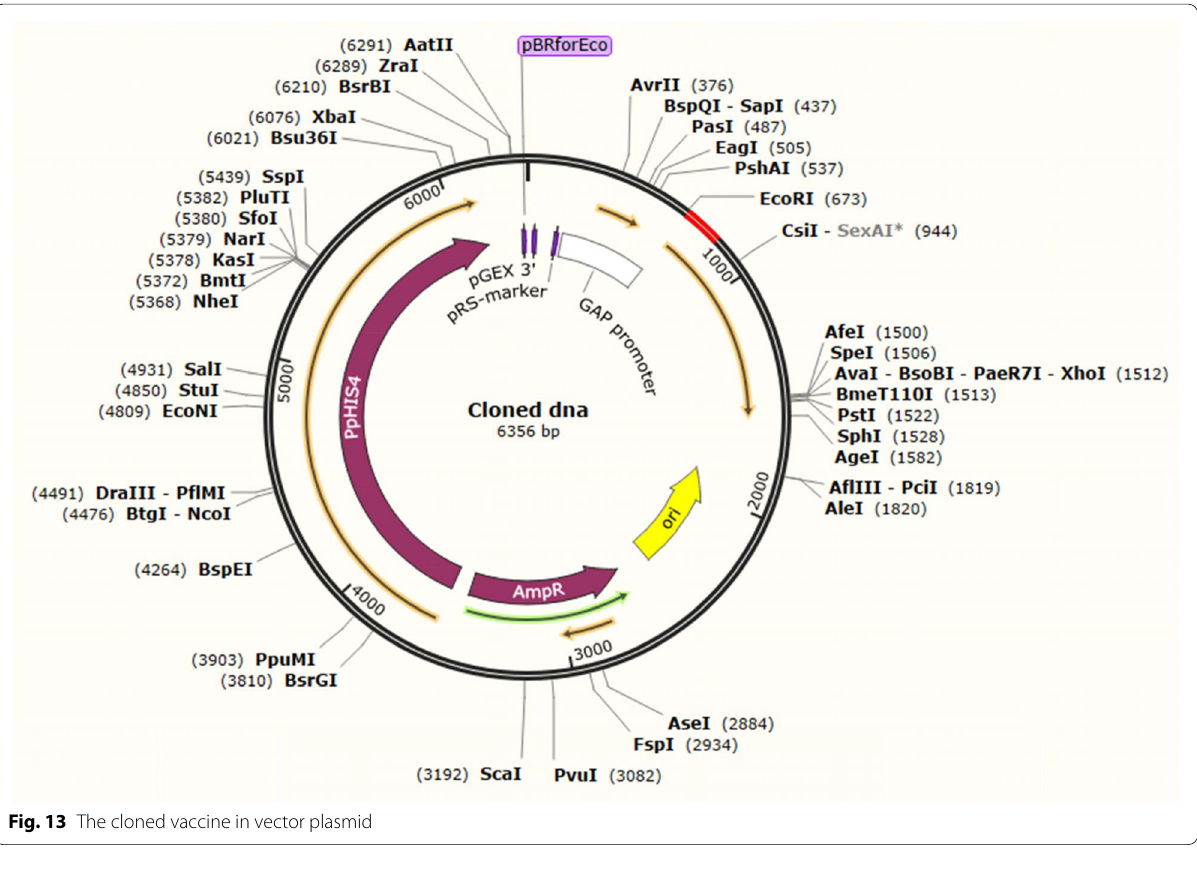
Fig. 13 The cloned vaccine in vector plasmid